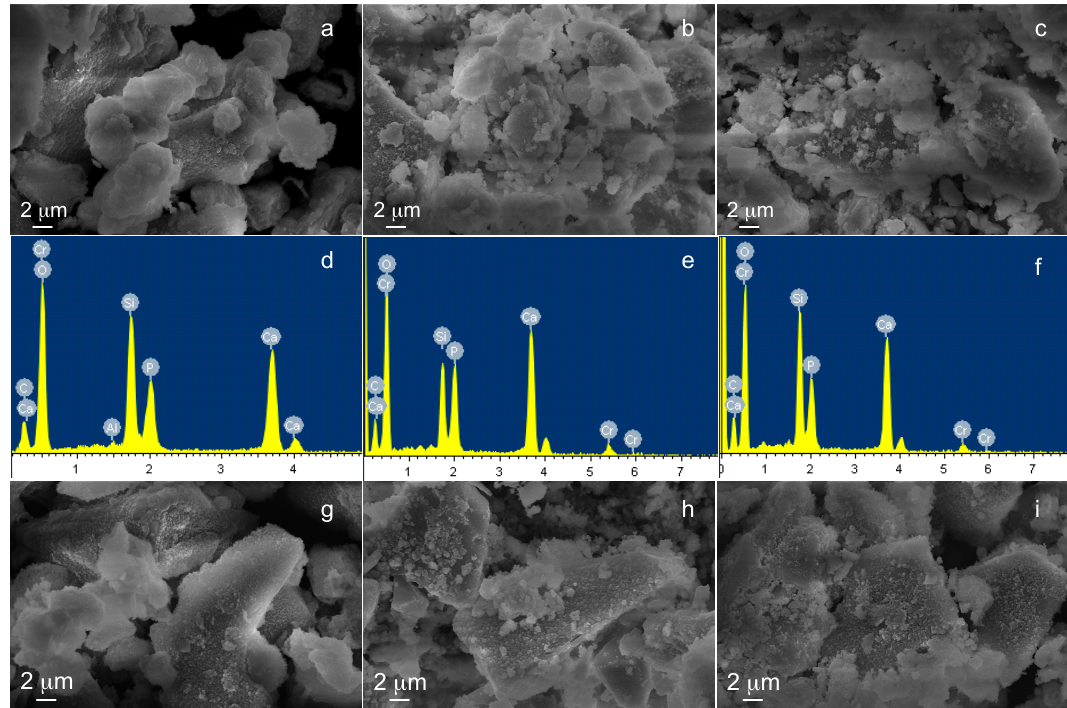
Figure 10. FESEM and EDS analysis of ( a , d ) SBA3; ( b , e ) SBA3-Cu0.01; and ( c , f ) SBA3-Cu0.05 after 21 days of immersion in SBF solution, and FESEM micrographs of ( g ) SBA3; ( h ) SBA3-Cu0.01; and ( i ) SBA3-Cu0.05 after 28 days of SBF treatment.